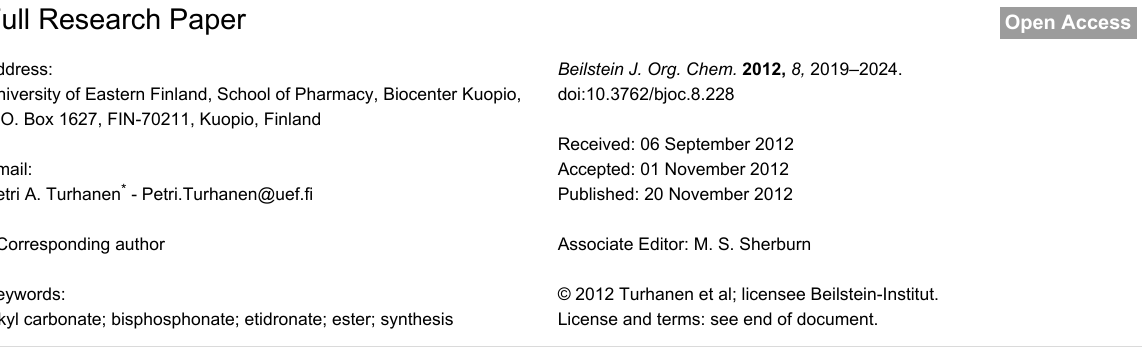
growth inhibitors for parasitic diseases such as malaria [8] and have found applications in crystal-engineering studies [9]. BP prodrugs have attracted recent interest due to their ability to inhibit isoprenoid biosynthesis